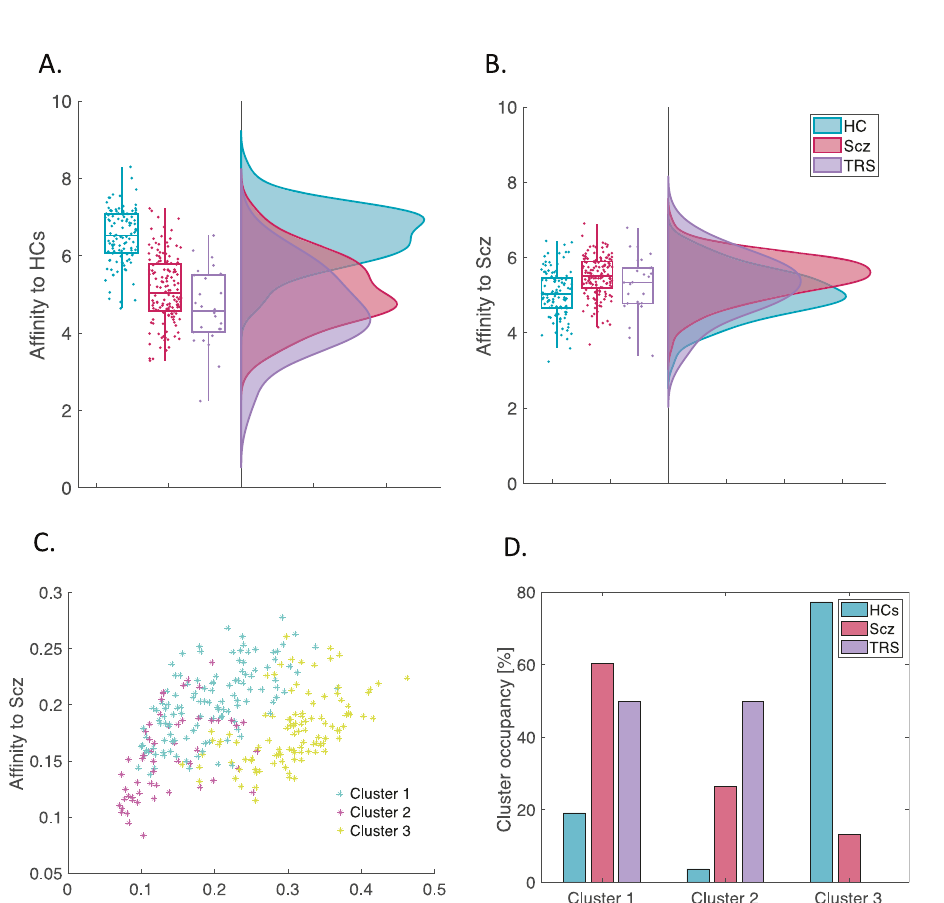
Fig. 2 Classi fi cation separability of TRS participants from healthy controls and Scz participants in the training dataset (metric: common neighbourhood-based af fi nity). TRS individuals showed low af fi nity to both ( A ) HCs and B Scz groups. C Post-hoc K-means clustering on the multivariate scores from the training dataset used for classi fi cation. Three clusters were identi fi ed based on af fi nity to HC and Scz groups using scores from composite af fi nity, common neighbourhood and common community-based metrics. D Group-wise composition of the three clusters (number of participants per group divided by group sample size in the training